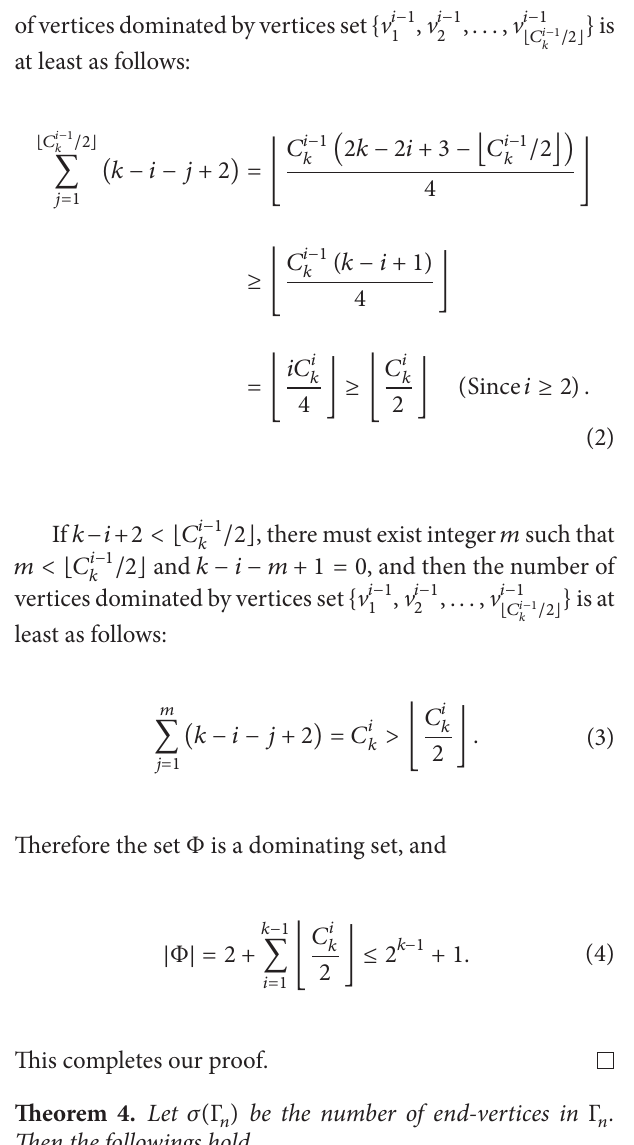
of vertices dominated by vertices set { V 𝑖−1 1 , V 𝑖−1 2 , . . . , V 𝑖−1 ⌊𝐶 𝑖−1